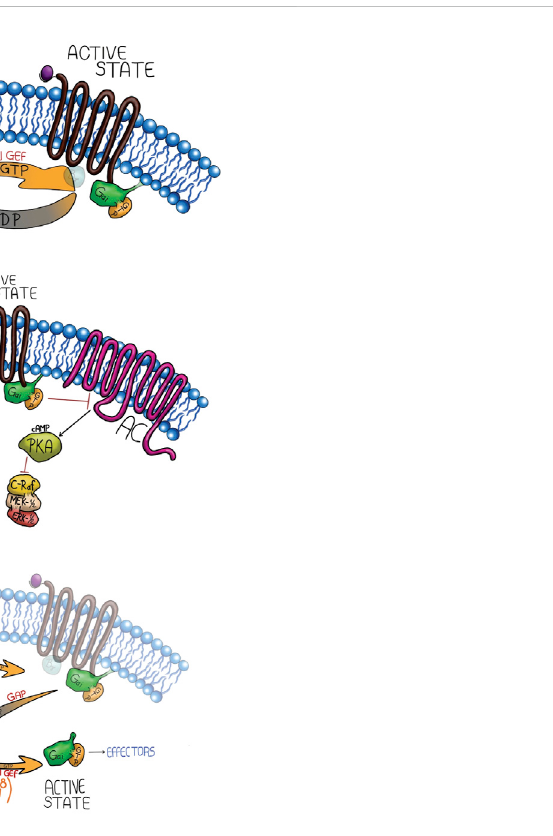
FIGURE 1 G α i canonical signaling network through receptor activation (A,B) and non-canonical activation (C) . (A) The upper panel shows the G-protein canonical signaling activation by the GPCR GEF activity, generating two active species (G α i-GTP and G βγ released). The intrinsic GTPase activity of the G α i subunit hydrolyze GTP to GDP, promoting its re-association with G βγ . (B) Canonical signaling pathway of G α i, which is inhibitory of Adenylyl Cyclase (AC), and G βγ activates MAPK signaling cascade. (C) The non-canonical activation signaling. During this process, G α i interacts with cytosolic GEFs such as Ric-8 or GIV which stimulate the GDP/GTP exchange, activating G α i in a receptor-independent manner potentiating the canonical signal or activating non-canonical